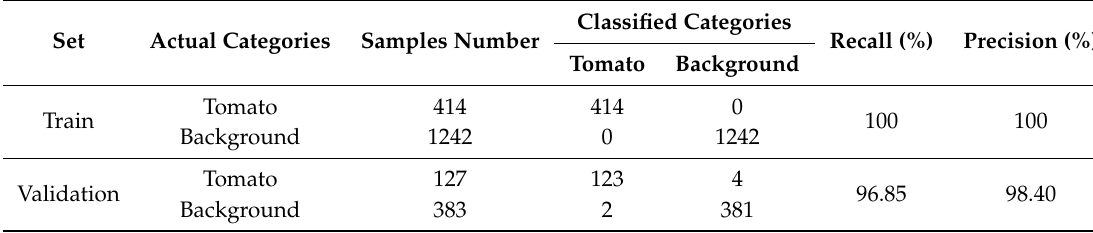
Table 2. The performance of the SVM classifier.